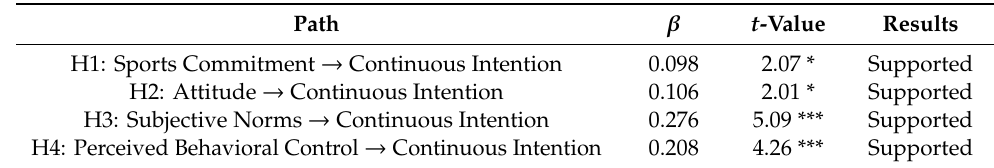
Table 5. Hypothesis testing